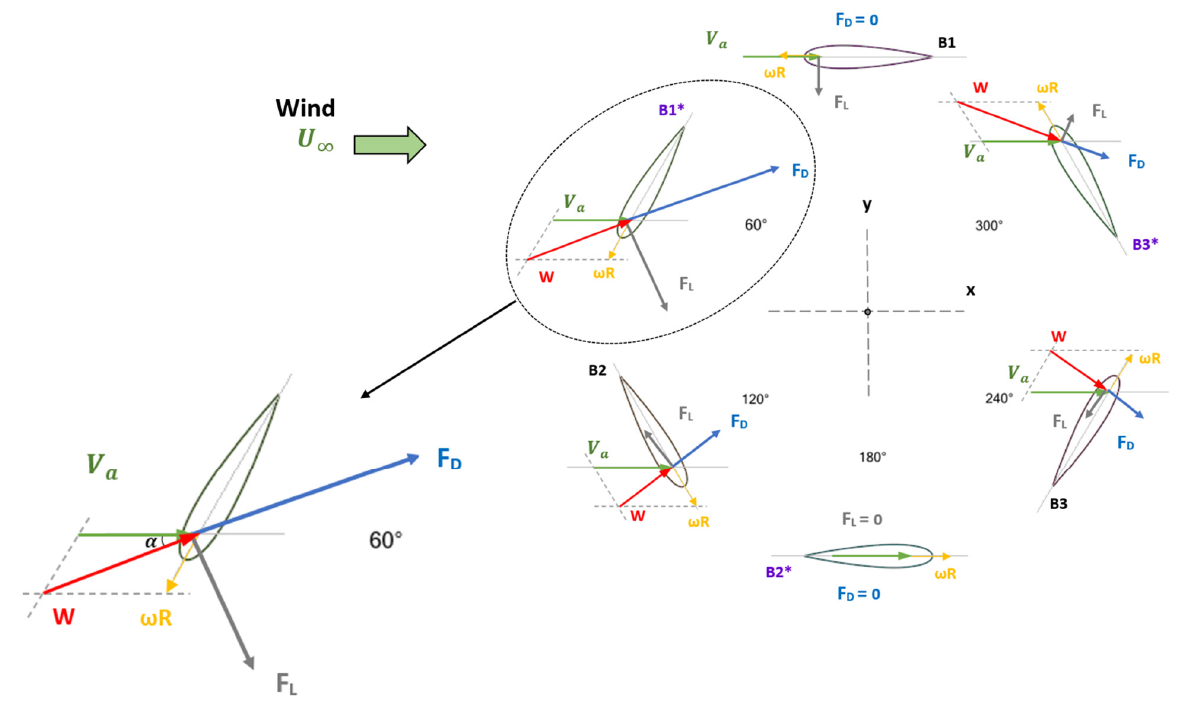
Figure 8. Wind and Blades Velocity Components with Forces acting on H-Darrieus’ blades at Various Azimuthal Positions, with FL, and FD representing the lift and drag forces vectors and W and V a representing the relative flow velocity and the induced velocity of wind.